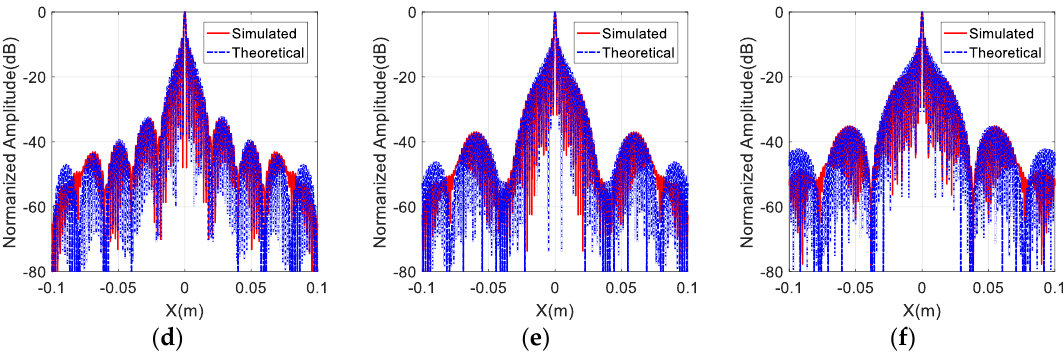
Figure 7. Comparison of the theoretical and simulated PSF: ( a ) Type I; ( b ) Type II; ( c ) Type III; ( d ) Type IV; ( e ) Type V; ( f ) Type VI. Table 3. Quantitative comparison of the different distribution antennas.